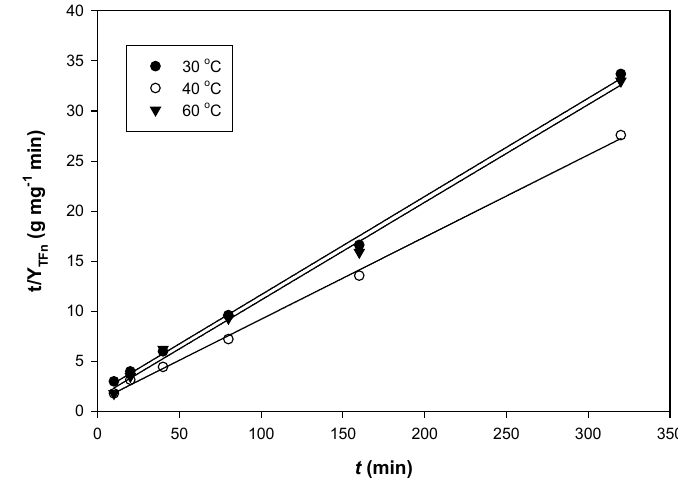
Figure 2. Second-order kinetics of TFn extraction from RGP using 0.5% ( w / v ) aqueous LA.